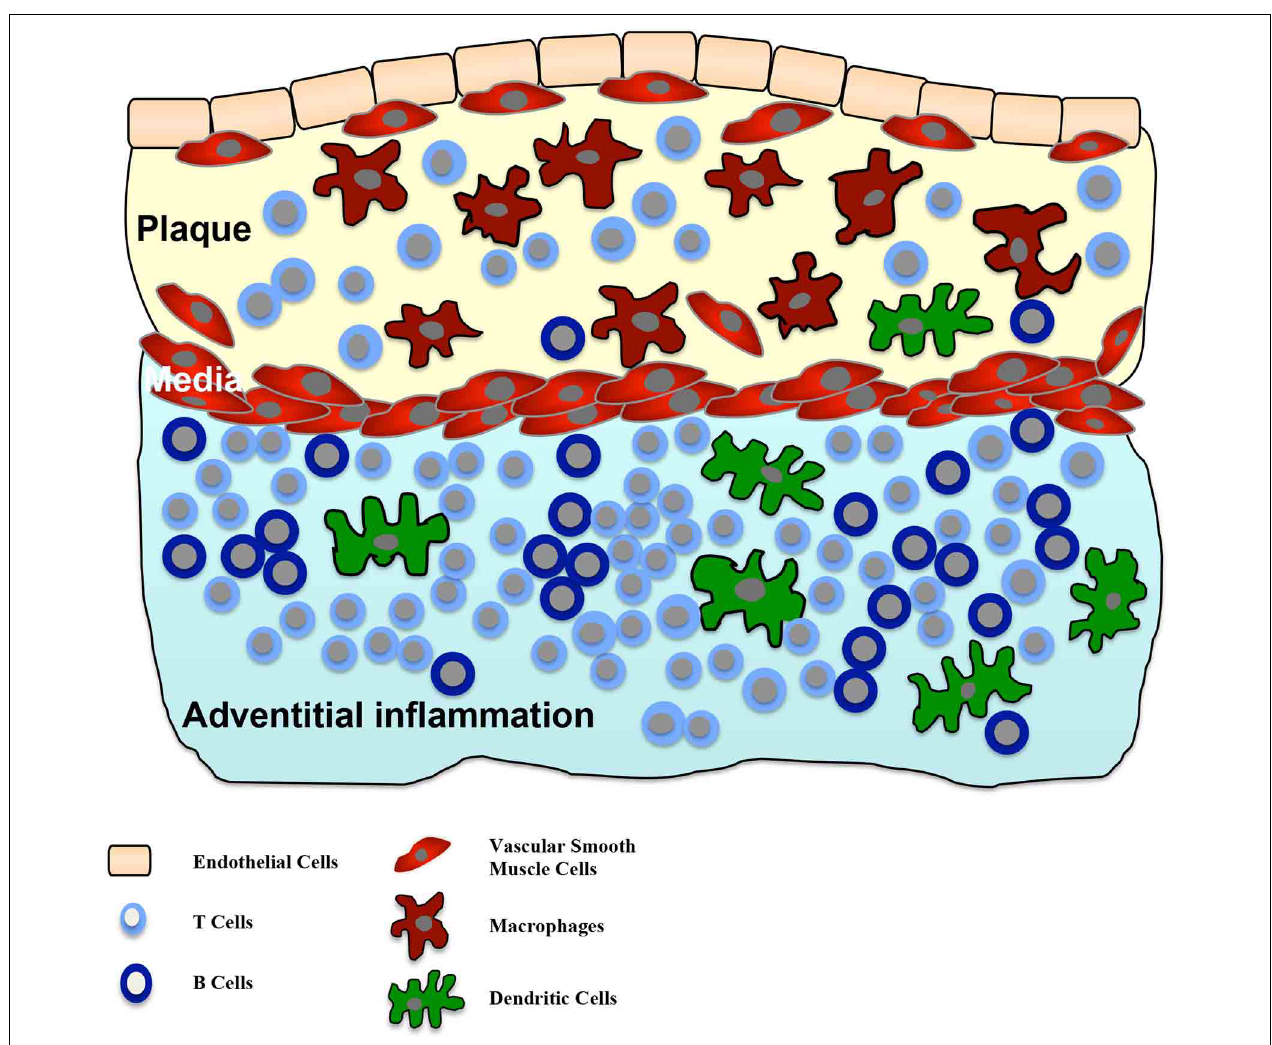
FIGURE 2 | Adventitial inflammation in atherosclerosis. Intimal atherosclerotic lesions are frequently accompanied by an inflammatory process in the adjacent adventitia. This inflammatory process is characterized by infiltration of T cells, B cells and dendritic cells in